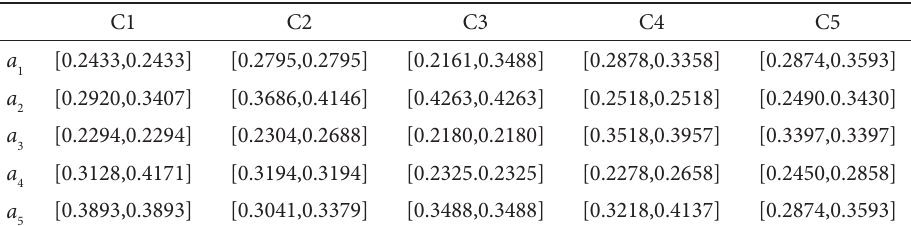
Table 3. The standardization of the expected values C1 C2 C3 C4